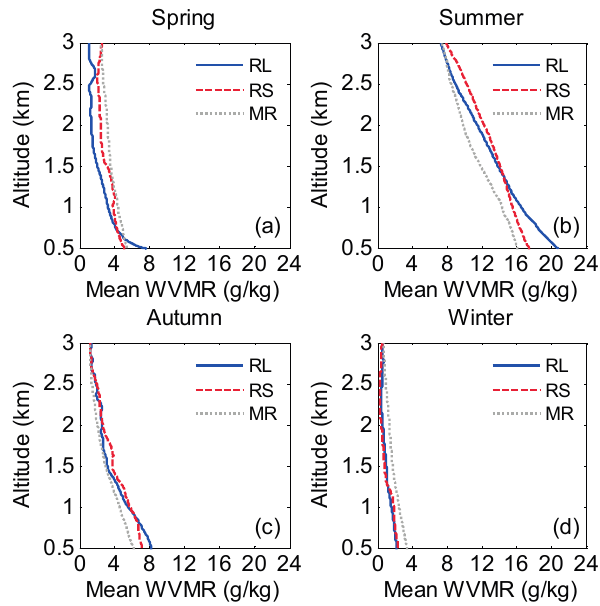
Figure 6. Quarterly mean water vapor mixing ratio (WVMR) measured by Raman Lidar (RL), RadioSonde (RS) and Microwave Radiometer (MR),